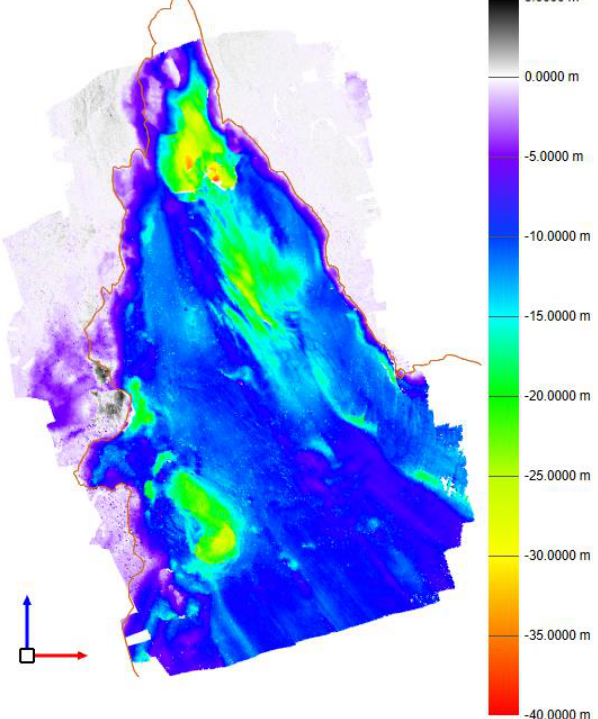
Figure 4. Height comparison map between 2014 DPC co- registered using ICPDPC method and 2016